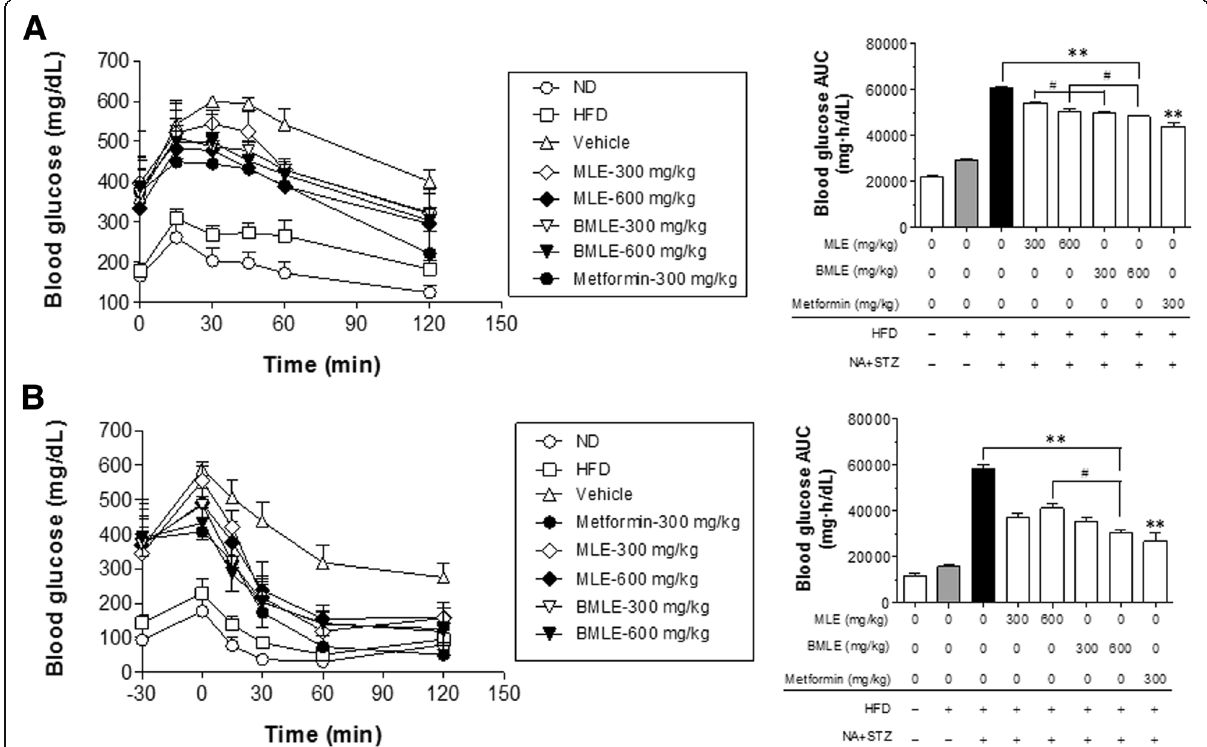
Fig. 5 Effects of bioconverted mulberry leaf extract (BMLE) and unaltered mulberry leaf extract (MLE) on oral glucose tolerance test (OGTT) and insulin tolerance test (ITT) in obese diabetic mice. MLE (300 and 600 mg/kg) or BMLE (300 and 600 mg/kg) were administered (PO) for 7 weeks in obese diabetic mice. Blood was collected from the tail vein ( a ) 15, 30, 45, 60, and 120 min after oral administration of glucose (2 g/kg) for the OGTT and ( b ) 30, 45, 60, and 120 min after administration (SC) of insulin (1 U/kg) for the ITT (see Materials and Methods). Metformin (300 mg/kg) was used as a positive control. Data are expressed as the mean ± SEM (n = 7), and significant changes among experimental groups were interpreted by converting all data into the area under the curve (AUC). ** P < 0.01, versus high-fat diet- fed (HFD) diabetic mice control (vehicle treatment), and # P < 0.05, vs.